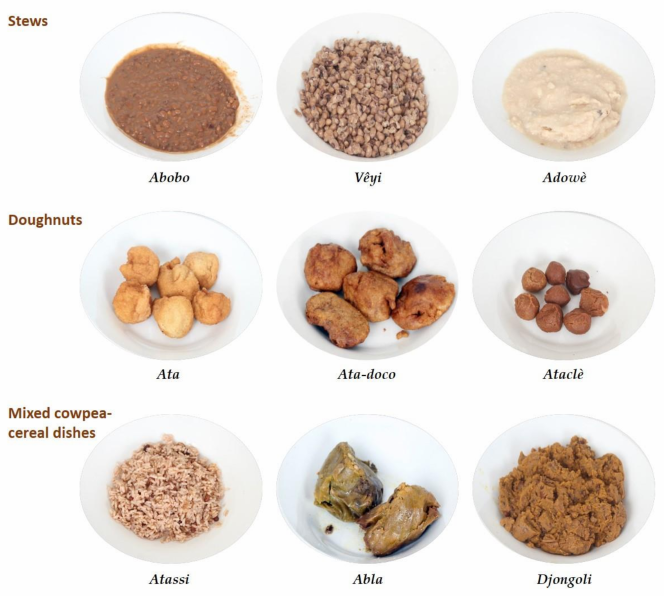
Figure 1. The nine traditional cowpea-based dishes consumed in Benin sampled in this